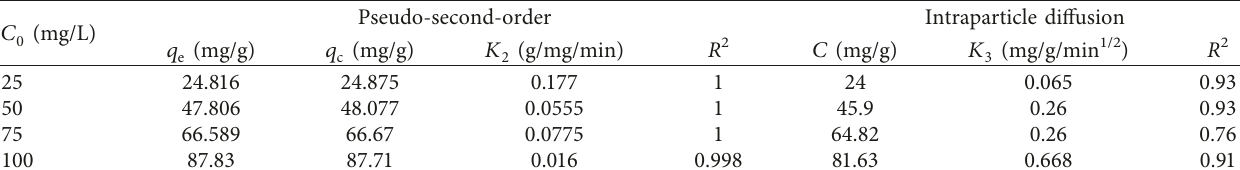
Table 6: Pseudo-second-order and intraparticle diffusion modelling results.